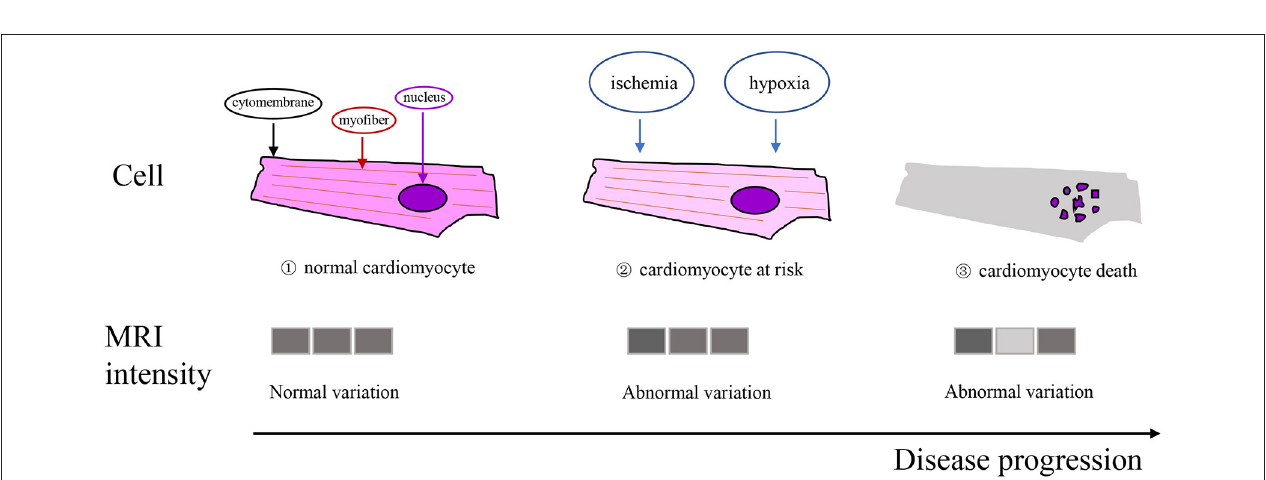
FIGURE 2 | Schematic illustration of the texture working hypothesis in myocardial infarction (MI). Top row: ischemia and hypoxia may cause cardiomyocyte at risk or death; (1), (2), and (3) represent normal cardiomyocyte, cardiomyocyte at risk, and cardiomyocyte death, respectively. Bottom row: changes in the statistical properties of the image intensities due to the persistent ischemia and hypoxia of cardiomyocytes may be reflected as certain textural patterns.